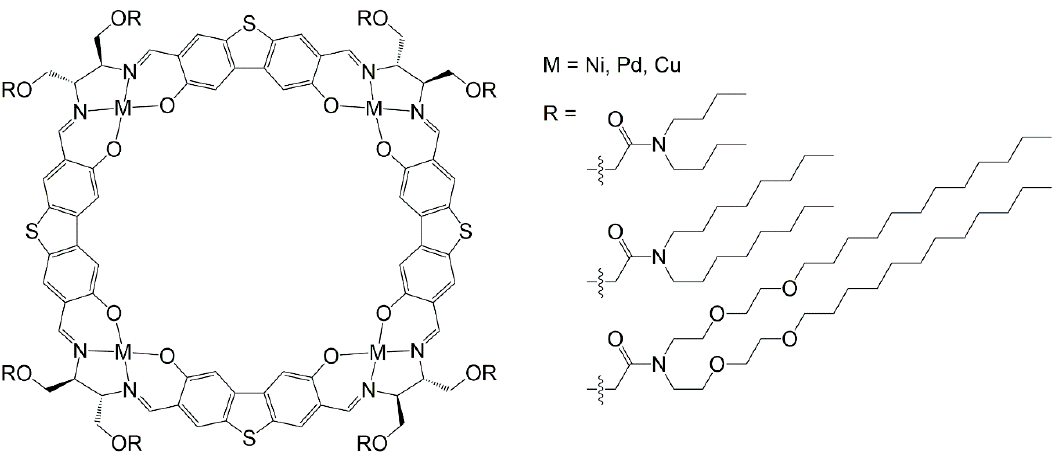
Figure 7. Rectangular columnar systems with thermotropic liquid-crystalline properties [34].